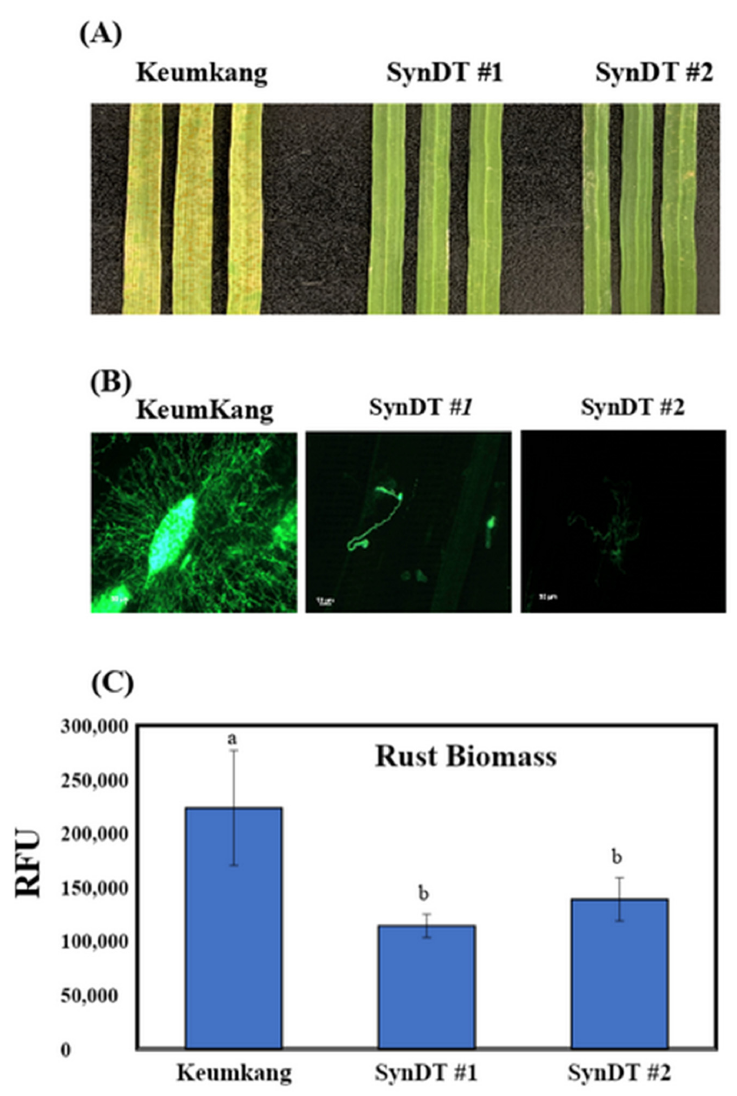
Figure 5. Growth performance of Keumkang and SynDT #1 and #2 in response to LR infection. ( A ) The phenotype of Keumkang, SynDT #1, and SynDT #2 in response to LR. ( B ) The development of hyphae under the microscope. ( C ) The quantification of rust biomass. Eight-day-old seedlings were exposed to LR. After 10 days, a picture was taken, and samples were collected for observations under a microscope or to quantify LR. The experiments were conducted at least twice to verify that the results were consistent. The standard deviation value was calculated from three replicates in each treatment. One-way ANOVA and Tukey’s test ( α = 0.05) were performed using SAS. Different letters (a, b, or c) indicate significant differences ( p <